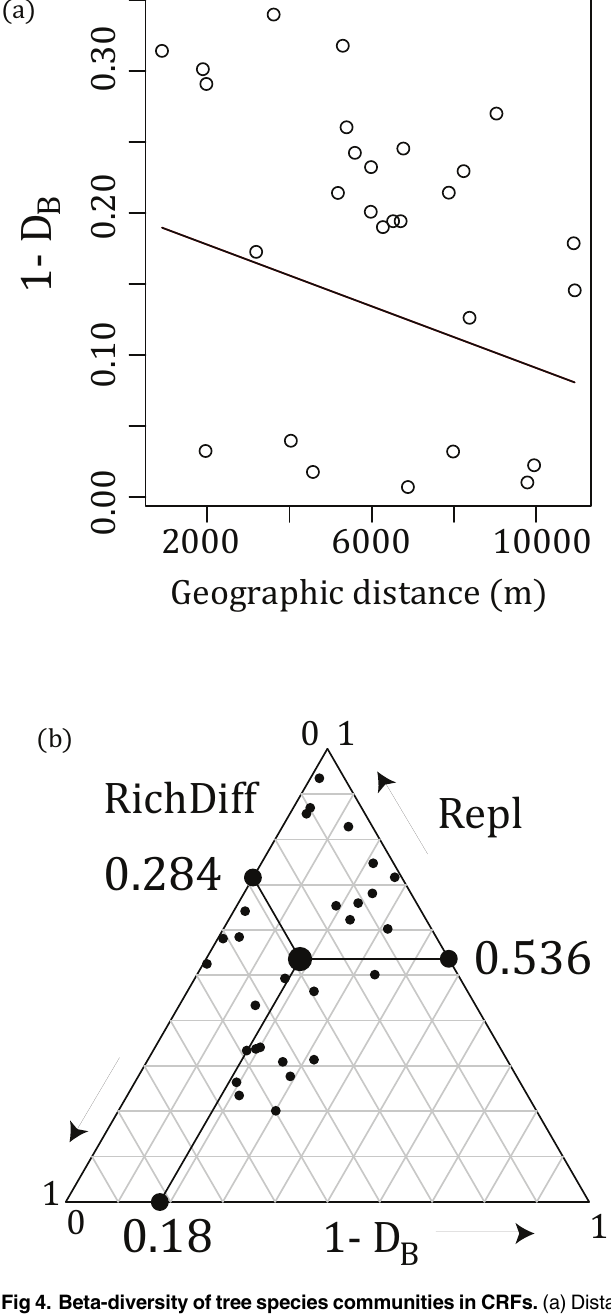
Fig 4. Beta-diversity of tree species communities in CRFs. (a) Distance-decay in the similarity (1- D B ) of tree community composition among CRFs. The fitted model from a generalizedlinear model is shown in black. (b) Triangulargraph of the relationshipamong1- D B (similarity), Repl (replacement), and RichDiff (richness difference). The large central dot is the centroid of the points, and the smaller dots represent the mean values of 1- D B , Repl , and RichDiff components.The fractions of replacement and richness difference to the total beta diversity are Repl Prop = 0.66 and RichDiff Prop = 0.34,